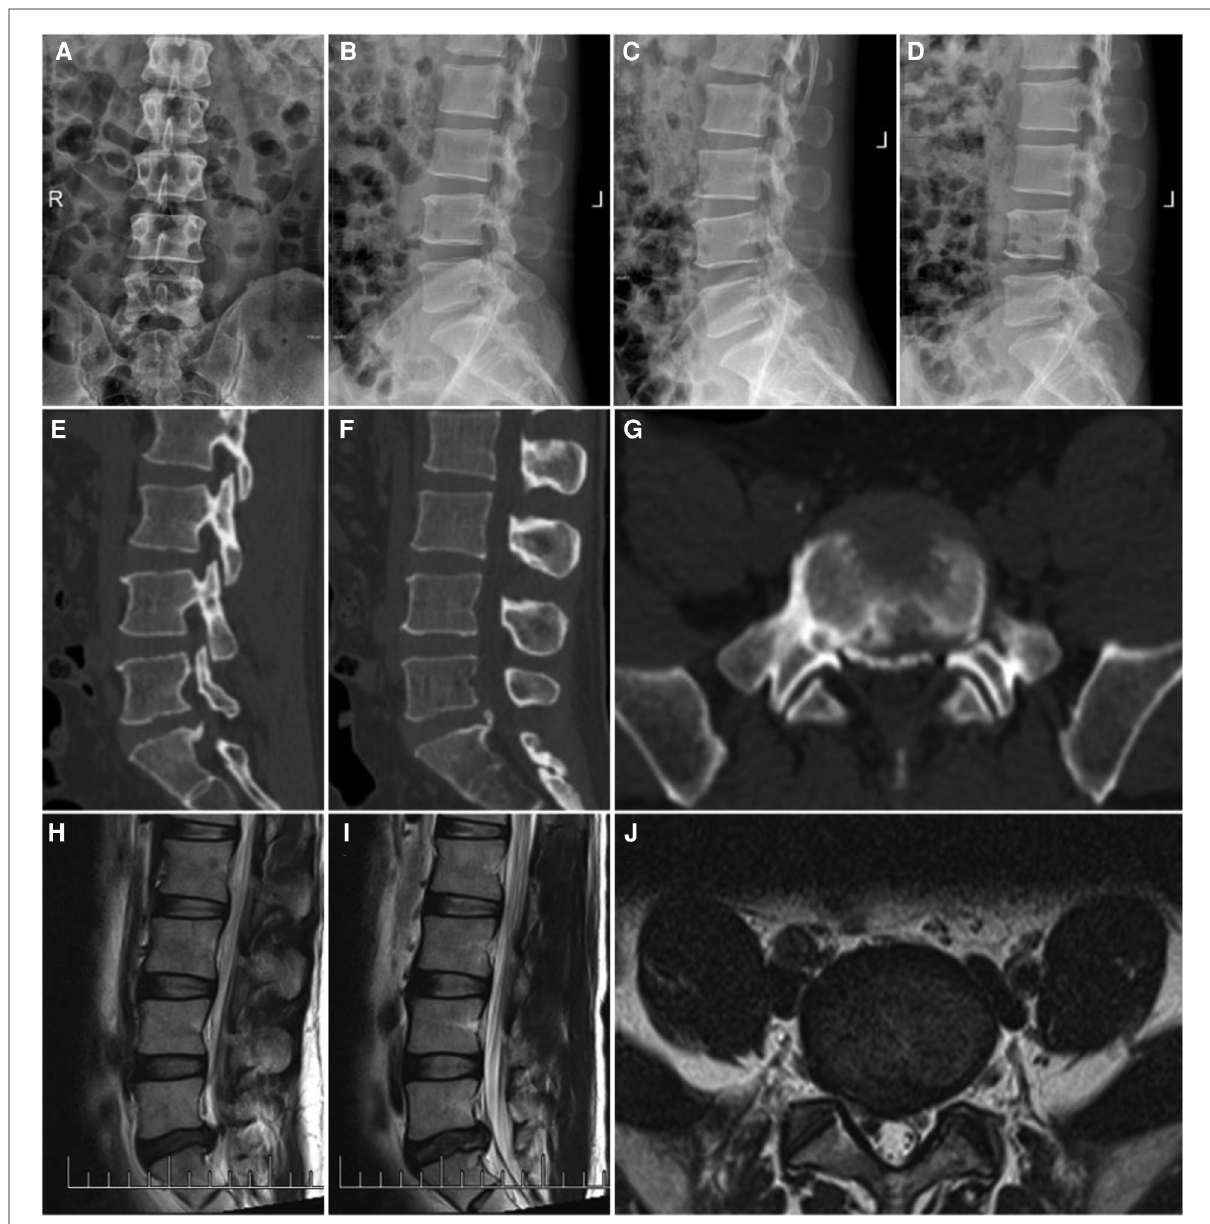
FIGURE 2 A 44-year-old man with LDH linked with PRAS was treated with PEID; the symptoms were mainly pain in the right lower limb. ( A,B ) CT scan of the lower lumbar spine: the detached bone fragment is shown to protrude into the posterior margin of the vertebral body and ( C,D ) MRI of the lumbar spine: the imaging fi ndings were consistent with that of the CT